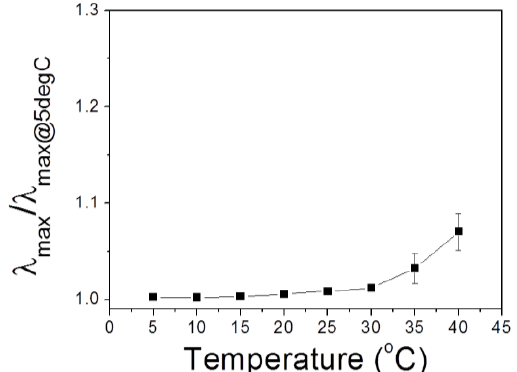
Figure 7. Temperature dependence on IOPG swelling. 2.5%-crosslinked PHEMA gel was used. Humidity was maintained at 20 ± 1% RH.